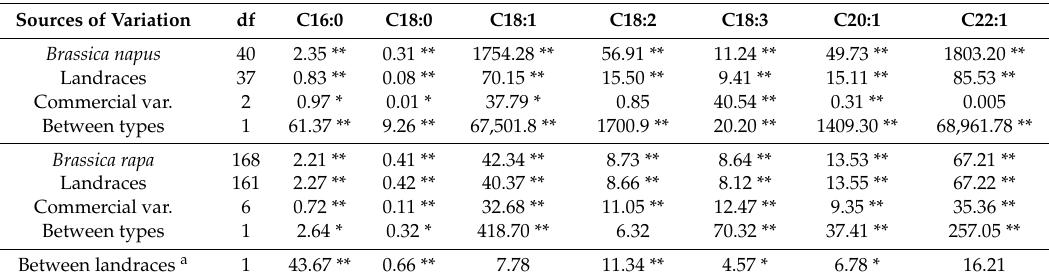
Table 2. Mean squares of the analysis of variance for fatty acids in the B. napus and B. rapa varieties